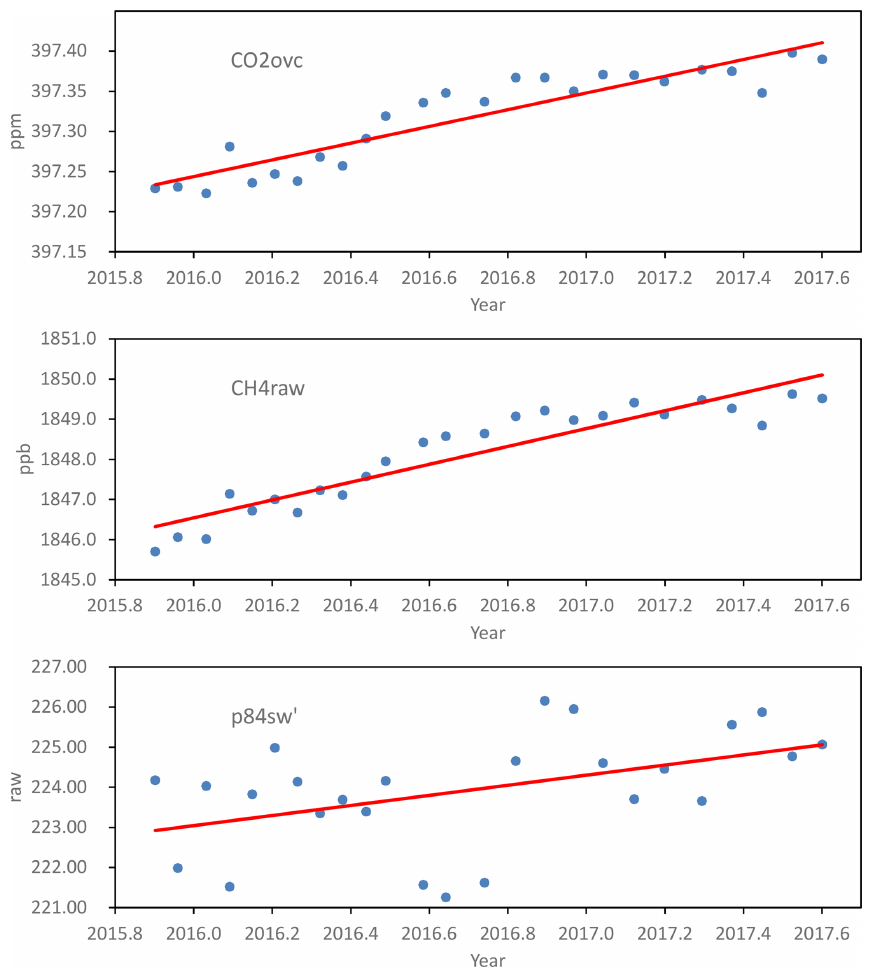
Figure 4. CRDS raw responses (blue dots) for a virtual tank (400ppm of CO 2 , 1850ppb of CH 4 , and 100ppb of CO) computed using the response functions obtained in the calibrations. Each red line corresponds to a least-square fitting of the data to a linear